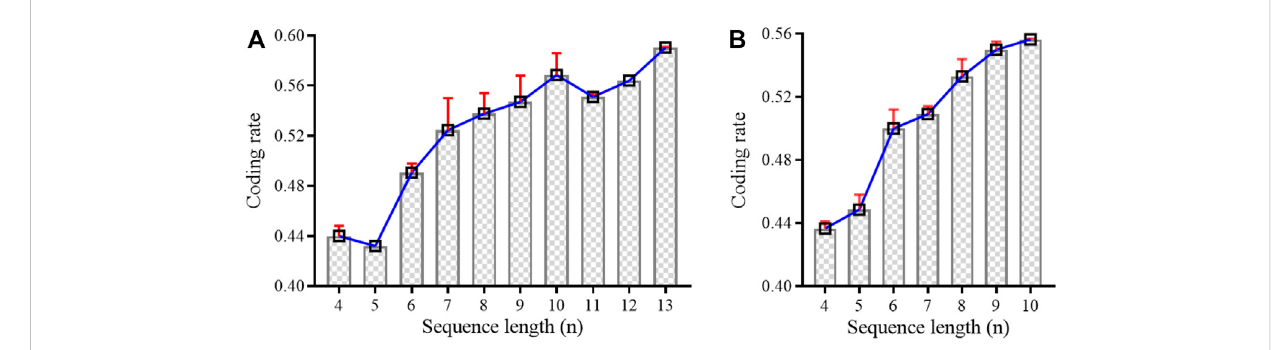
FIGURE 6 DNA-coding rate comparison at d = 3 using standard error mean based on (A) Table 3 and (B) Table 4.